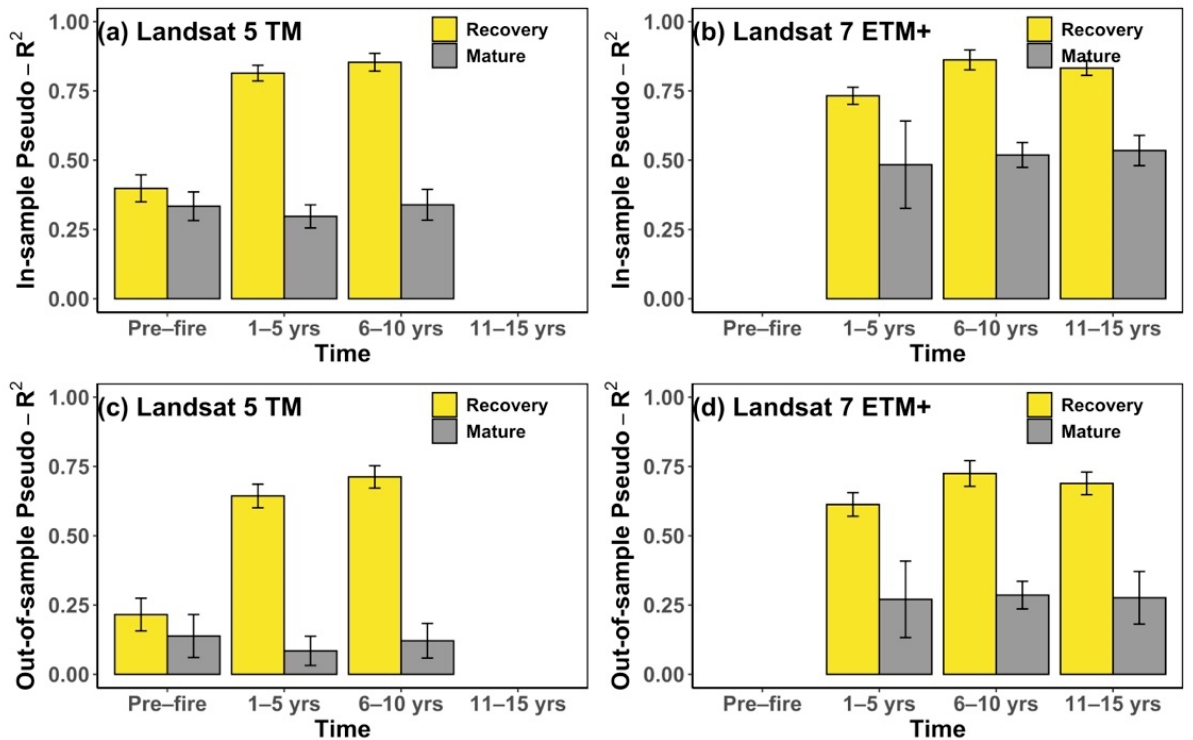
Figure 7. In-sample ( a , b ) and out-of-sample ( c , d ) coefficient of determination (Pseudo-R 2 ) for the relationship between measured and simulated NDVI by using Bayesian Additive regression Trees models (mean ± standard error). Models were performed for each site at different times since fire respectively (four periods: prior to fire event =, from 1987 to the fire year (with TM-derived time series), first 1–5 years, 6–10 years and more than 10 years post-fire (with ETM+-derived time series)). Recovery Pseudo-R 2 was calculated based on sites that were dominated by grass, Scots pines and a mixture of species (yellow bars), and Mature Pseudo-R 2 were from mature Scots pines only (grey bars).